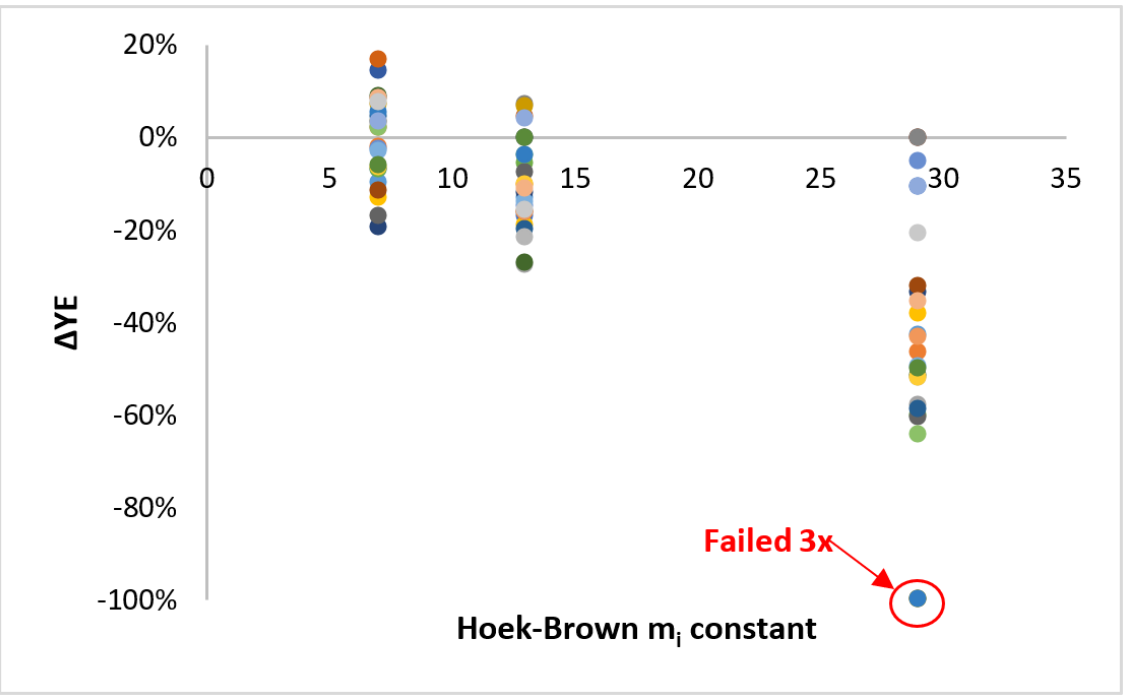
Figure 10. Variation of the relative deviation of the number of yielded elements for the three rock types presented in Table 2; rocks are represented by their mi Hoek & Brown constant.